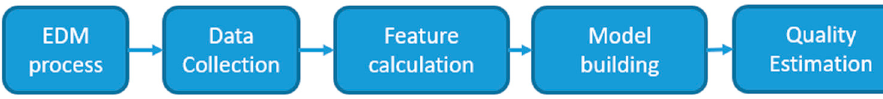
Figure 12. The flowchart of EDM process analysis.